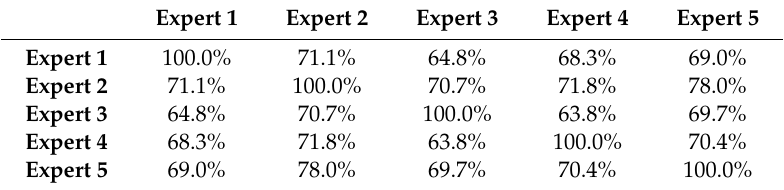
Table 1. Percentage agreement on the primary outcome of treatment between di ff erent experts.